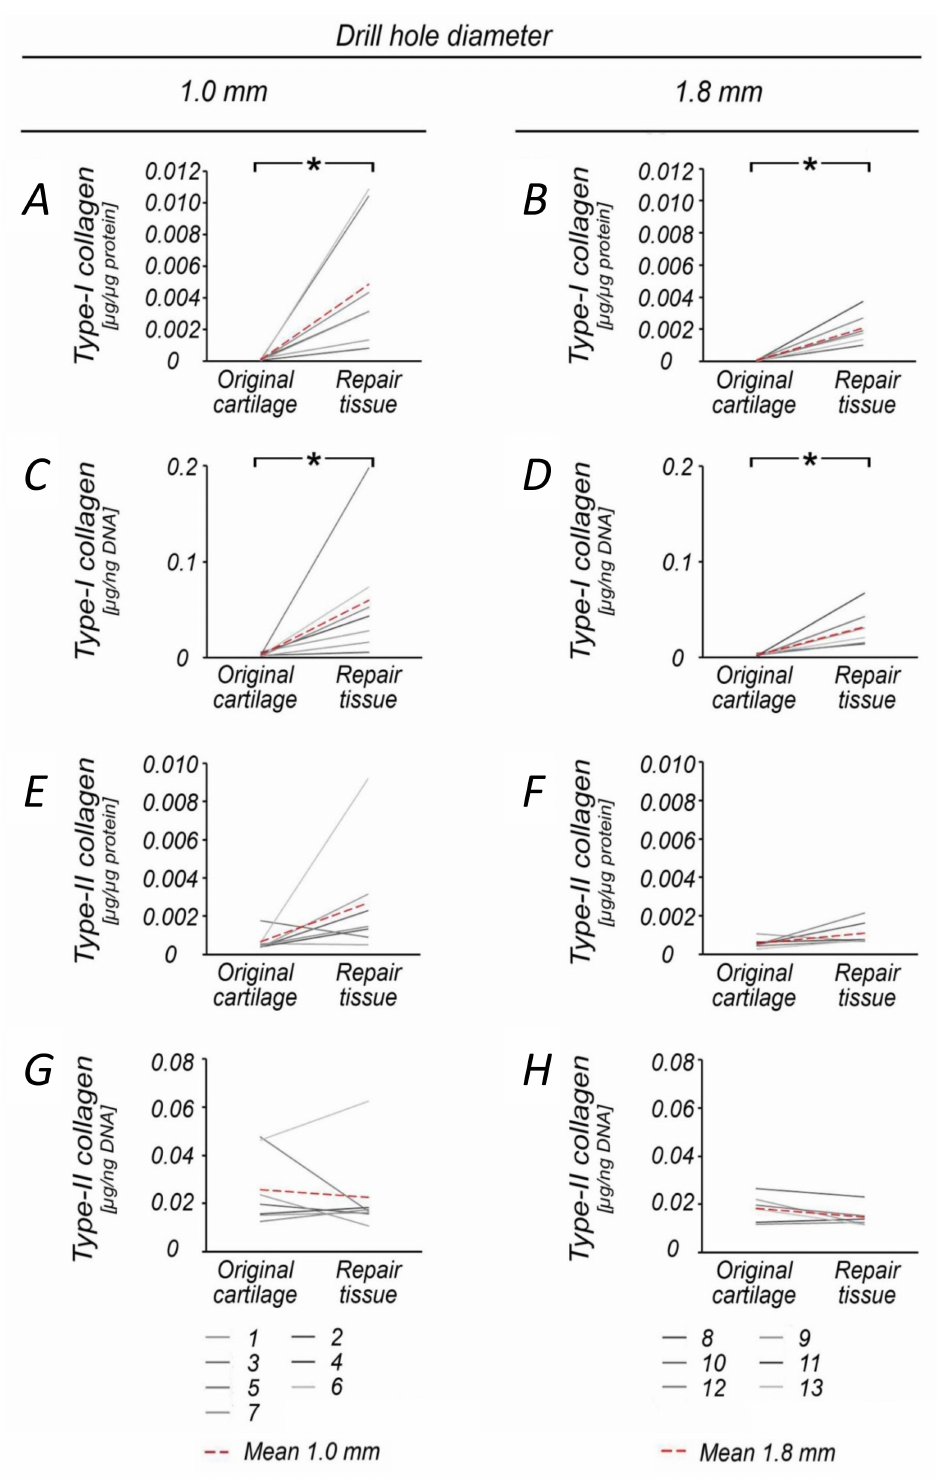
Figure 2. Comparison of Type I and Type II collagen content within original and repair cartilage following 1.0 and 1.8 mm subchondral drilling. Within both groups, the repair cartilage showed significantly increased Type I collagen content ( A , B ) and Type I collagen / DNA ratio ( C , D ) when compared to the original articular cartilage, reflective of early osteoarthritis. Analysis of Type II collagen content revealed no significant di ff erences between repair and original cartilage ( E – H ). Numbers 1–13 represent individual animals. Red dotted lines indicate mean values. * p <